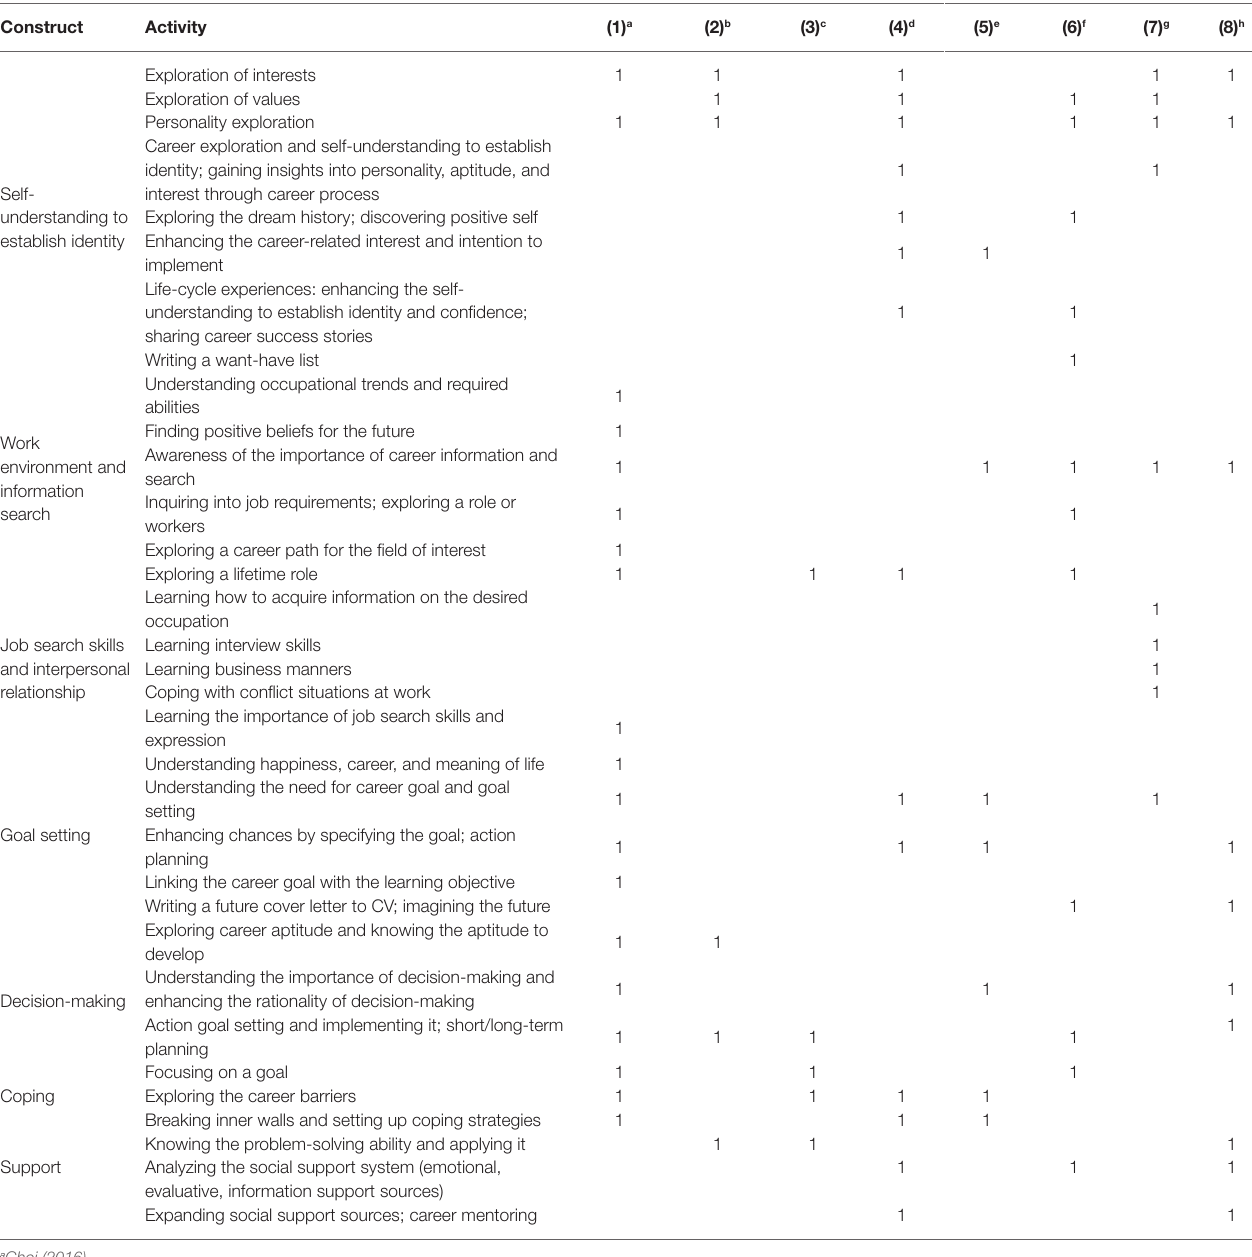
TABLE 1 | Content areas of career adaptability